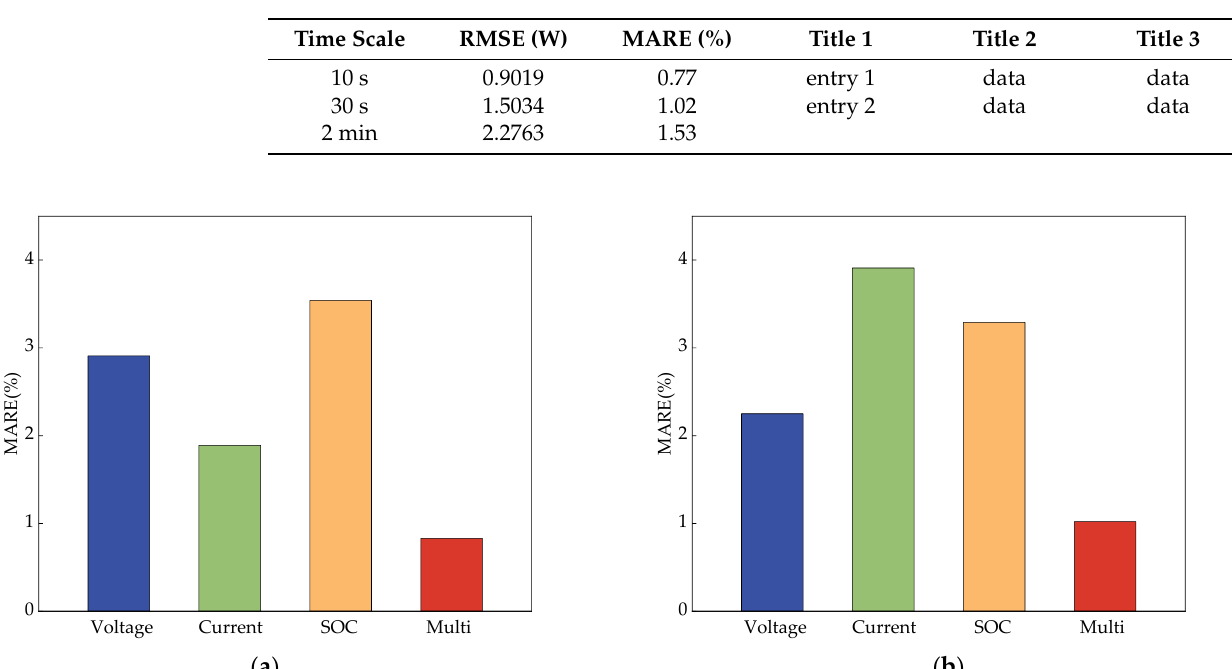
Figure 20. Results of peak charge power relative error: ( a ) 10 s; ( b ) 30 s; ( c ) 2 min. Table 2. Estimation errors of sustained peak charging power for different time scales.